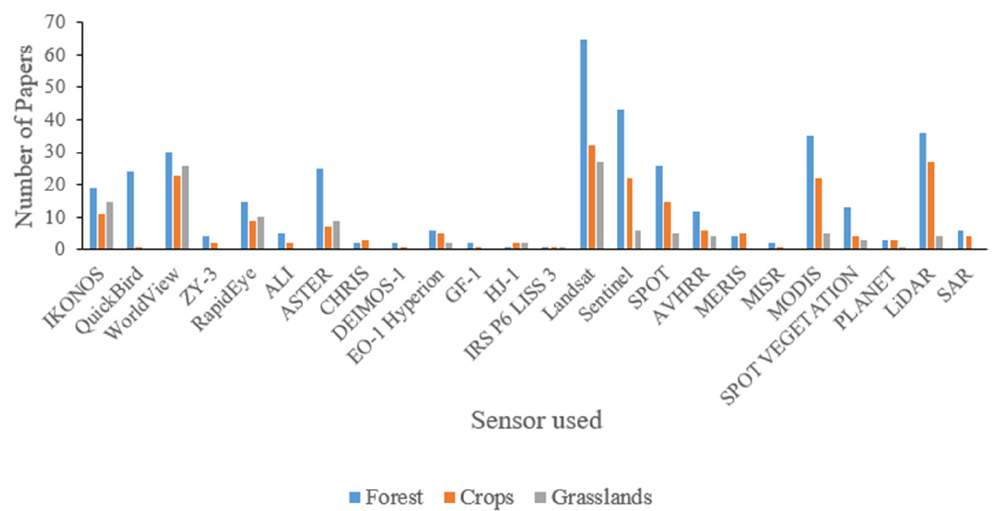
Figure 5. Sensors used to estimate LAI for forest, crop and grassland.